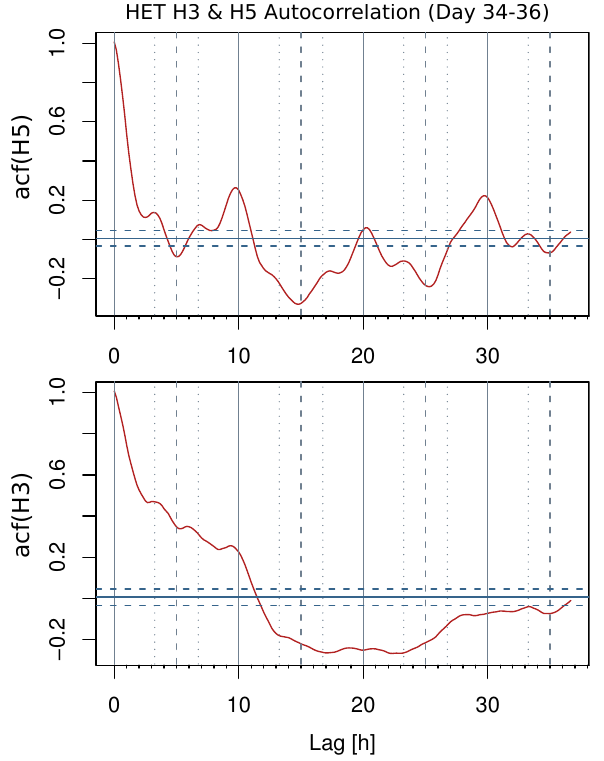
Fig. 3. Same as Fig. 2 but for the time interval day 36 to 38.5. The major and minor peaks are still present. Four current sheet crossing are indicated by the red vertical lines and reveal that the minor peaks occur when the spacecraft moves across the current sheet from south Fig. 4. Autocorrelation of the HET H5 (top) and H3 (bottom) chan- to north. Note the scale change in | B | at day 37.5. nels. The solid lines indicate the 10h periodicity that is well pro- Fig. 4. Autocorrelation of the HET H5 (top) and H3 (bottom) chan- nounced for the H5 channel. The dashed lines lie in the middle of nels. The solid lines indicate the 10 h periodicity that is well pro- the 10h intervals. However, another temporal variation can be iden- nounced for the H5 channel. The dashed lines lie in the middle of tified in the H5 data as indicated by the dotted lines. These peaks are the 10 h intervals. However, another temporal variation can be iden- shifted by ± 3.25h with respect to the major 10h peaks. The same Fig. 5. Result of the ordinal autocorrelation analysis of the H3/H5 tified in the H5 data as indicated by the dotted lines. These peaks are analysis for the H3 channel shows no clear modulation, suggesting (red) and E4/E12 (blue) ratios for days 34-36. Similar to Fig. 4, shifted by ± 3 . 25 h with respect to the major 10 h peaks. The same that the spectral rocking is mainly due to the higher energy channel this Figure reflects the temporal variation related to the clock mech- (i.e. H5). analysis for the H3 channel shows no clear modulation, suggesting anism, but also shows evidence for a second periodic modulation that the spectral rocking is mainly due to the higher energy channel, related to the minor peaks in the spectral index. The shift between both variations is ∼ 3 . 25 h. i.e. H5. the H5 channel tends to be better pronounced with respect to the amplitude of its temporal variations.